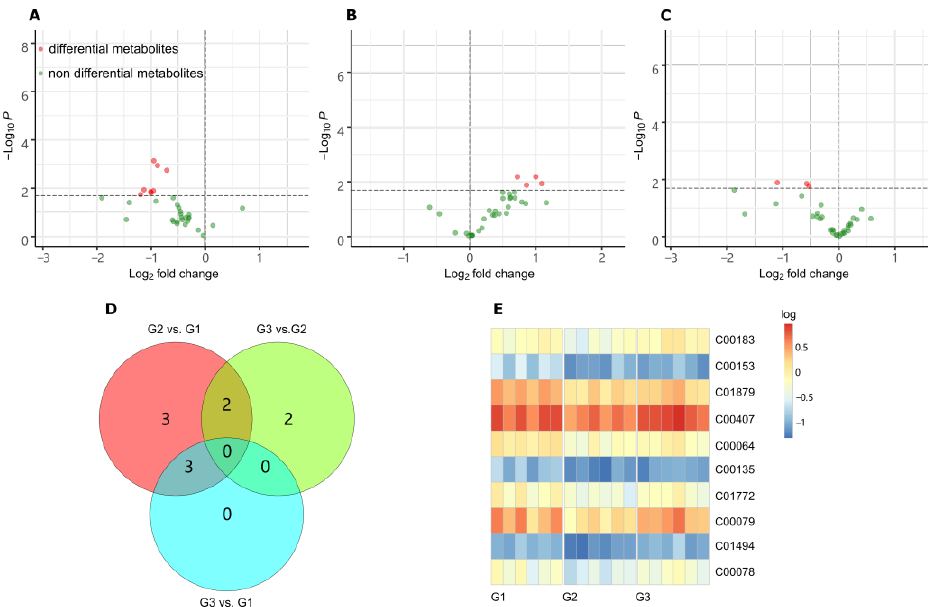
Figure 4. LC-MS/MS Metabolites analysis. ( A ) Volcano plot of differential metabolites (DMs) in the contrast of G2 vs. G1 ( p < 0.02). ( B ) Volcano plot of DMs in the contrast of G3 vs. G2 ( p < 0.02). ( C ) Volcano plot of DMs in the contrast of G3 vs. G1 ( p < 0.02). ( D ) Venn plot of DM counts based on contrasts. ( E ) Heatmap of DMs variation. The vertical coordinate is the KEGG ID of DMs. Color represents the logarithm of the relative content.